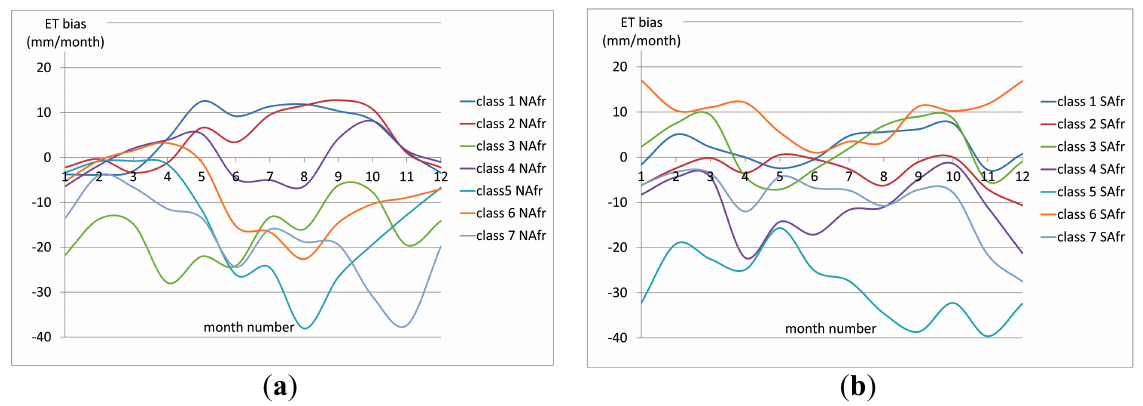
Figure 8. Bias curves obtained in rain–fed pixels of the sectors ( a ) North Africa and ( b ) South